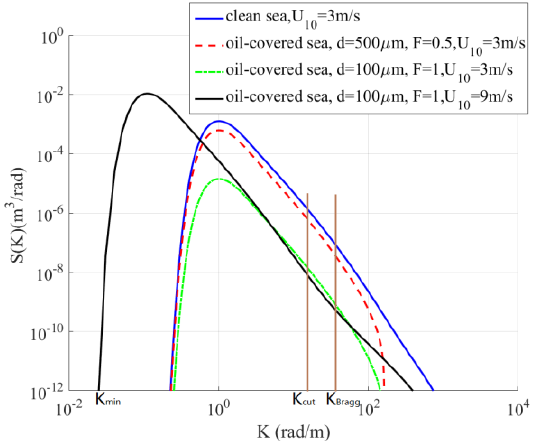
Figure 1. Comparison between clean sea spectrum and oil film sea spectra.